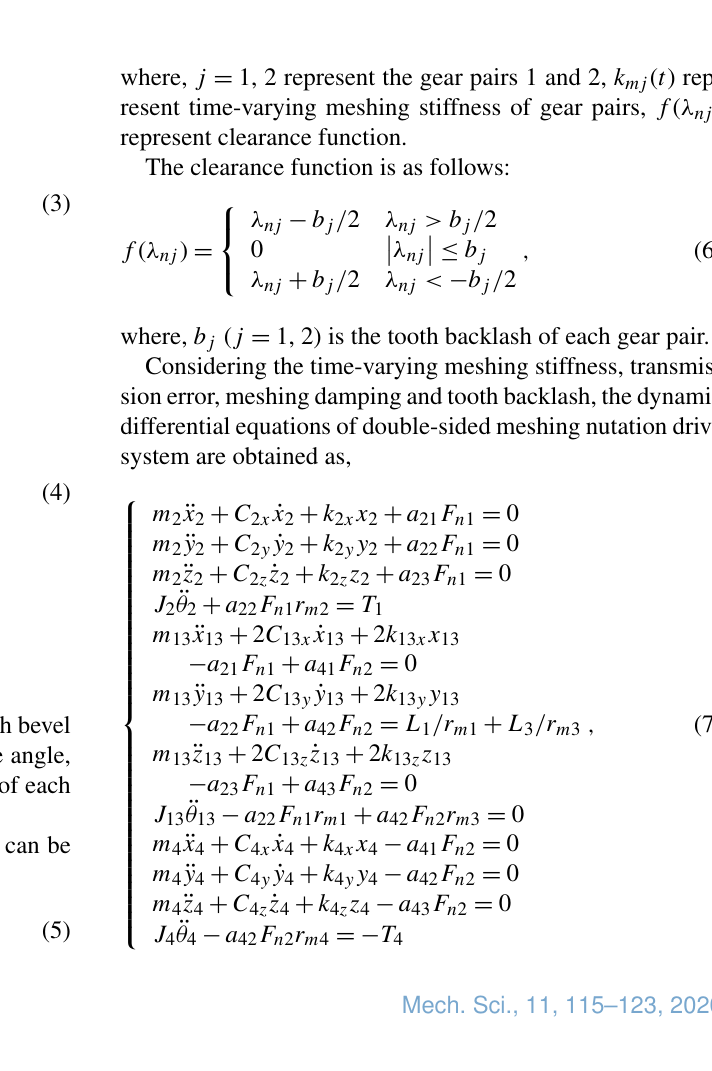
Figure 2. Physical model of nutation